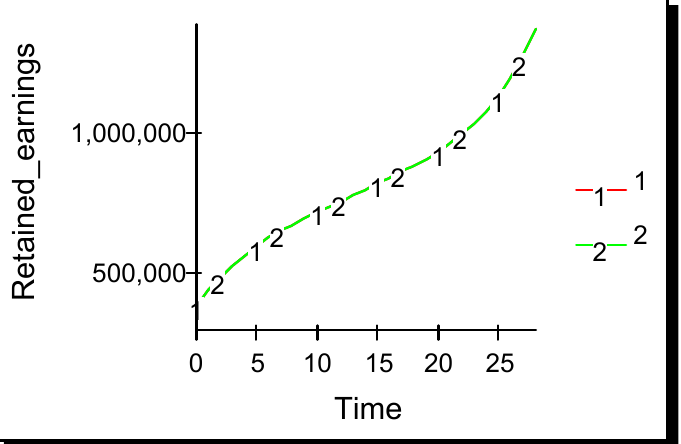
Figure 6. Symmetric advertising, above threshold. Advertising effectiveness: φ 1 = φ 2 = 0.000011.